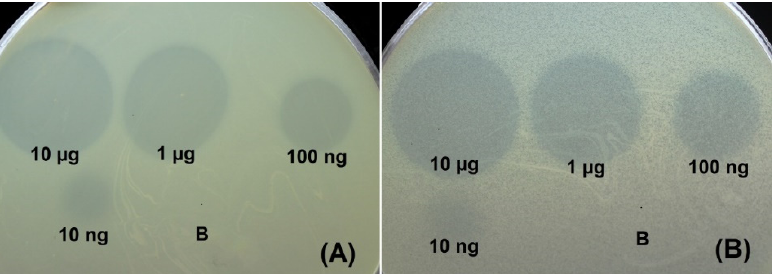
Figure 5. Spot test with serial 10-fold titration of purified recombinant depolymerases DpoB8300 ( A ) and DpoAB5075 ( B ) and on A. baumannii B8300 and AYE lawns, respectively, after 18 h of incubation; B—buffer (20 mM Tris-HCl, pH 7.5, and 150 mM NaCl) for storage of the proteins as a negative control.